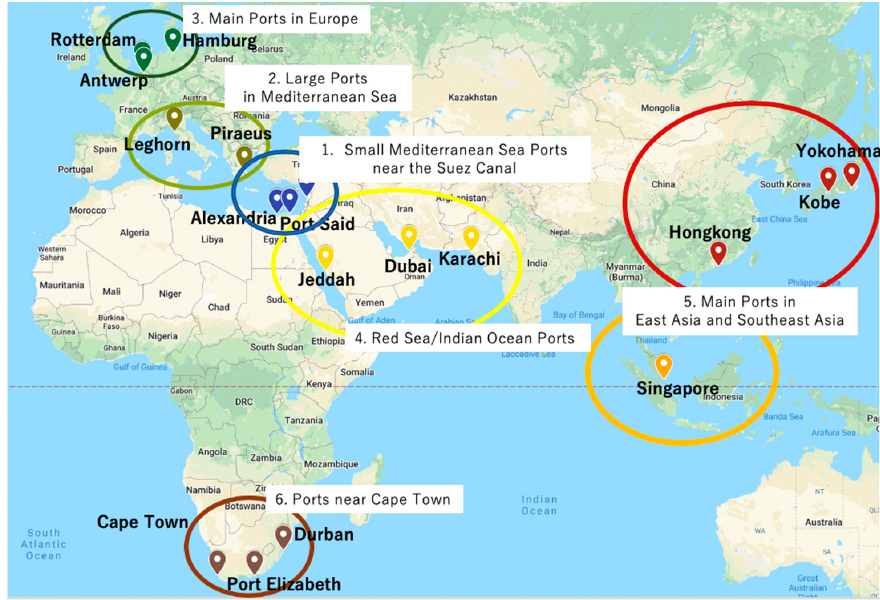
Figure 11. Classification of port groups of the world with representative ports.